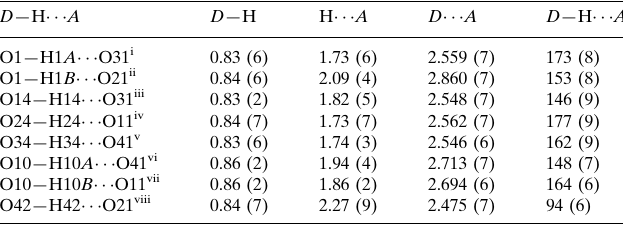
Hydrogen-bond geometry (A˚ , (cid:2)